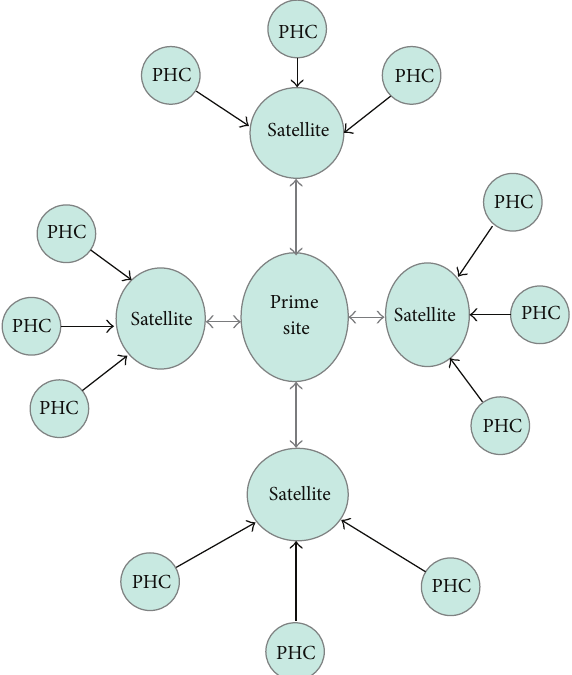
Figure 1: Hub-and-spoke model of ART decentralization in Jos, Nigeria (PHC: primary health centre; ↔ two-way flow of referrals; and → one-way flow of